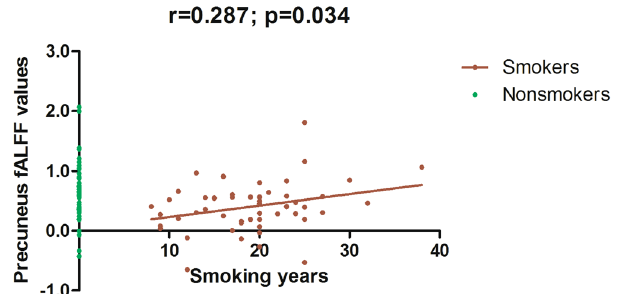
Figure 2. The fALFF values of the left precuneus were positively correlated with smoking years across the smokers (r = 0.287; p =